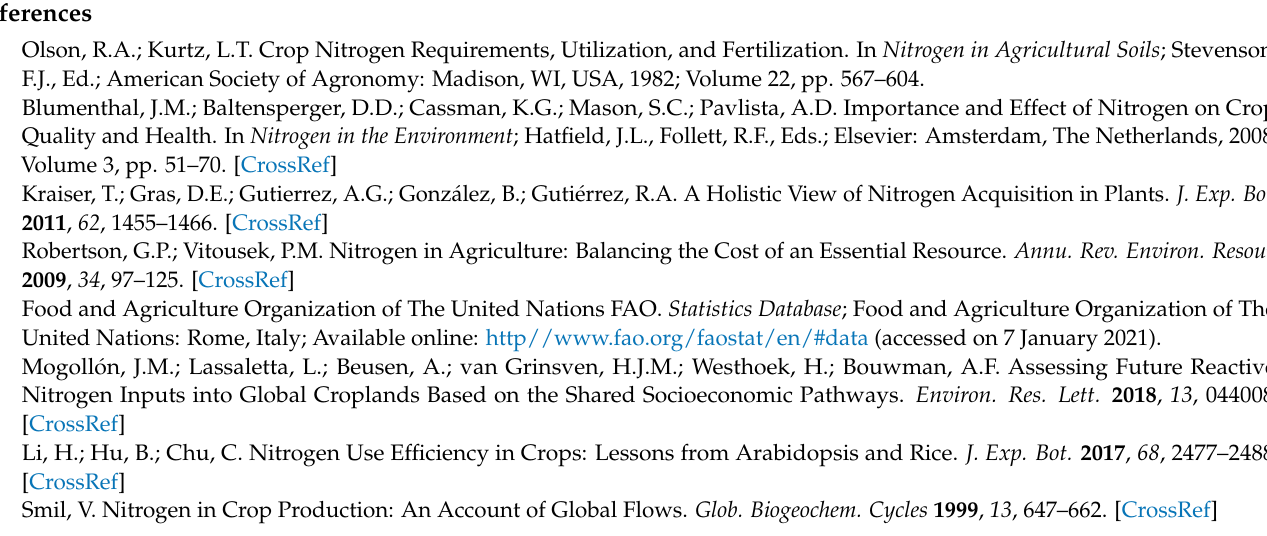
(RGR) in tomato, Figure S2: Effect of nitrogen supply levels on the uptake of micronutrients, Figure S3: Effect of nitrogen supply levels on amino acid contents in the leaves and roots of plants grown using 8 mM N and 4 mM N for 20 days, Figure S4: Verification of the transcriptomic analysis by RT-qPCR of selected DEGs from the C and N metabolisms, Figure S5: Gene co-expression clusters of roots and leaves under nitrogen limitation conditions (4 mM N), Figure S6: Metabolic gene expression changes under limiting N supply (4 mM N) analyzed by the MapMan tool, Figure S7: Effect of nitrogen supply levels on flavonoid and phenylpropanoid contents in mature red fruits, Table S1: Primers used in RT-qPCR analyses, Table S2: List of up- and downregulated genes in tomato leaves using 4 mM N when compared to 8 mM N, Table S3: List of up- and downregulated genes in tomato roots using 4 mM N when compared to 8 mM N, Table S4: List of upregulated and downregulated genes shared by leaves and roots, Table S5: List of DEGs corresponding to transcription factors in tomato leaves and roots using 4 mM N, Table S6: List of genes in root clusters under N limitation, Table S7: List of genes in leaf clusters under N